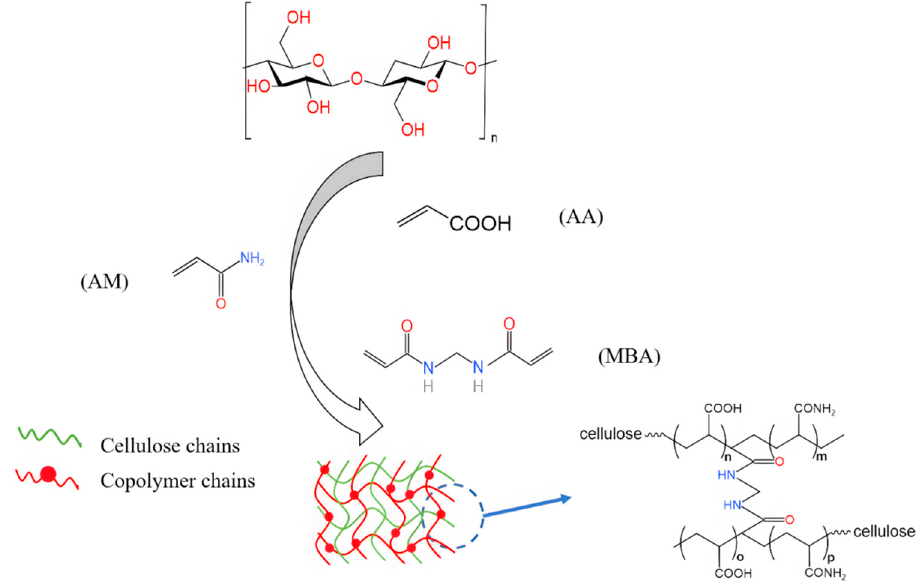
Figure 2. The synthesis scheme of RIR/AA-co-AM hydrogel.